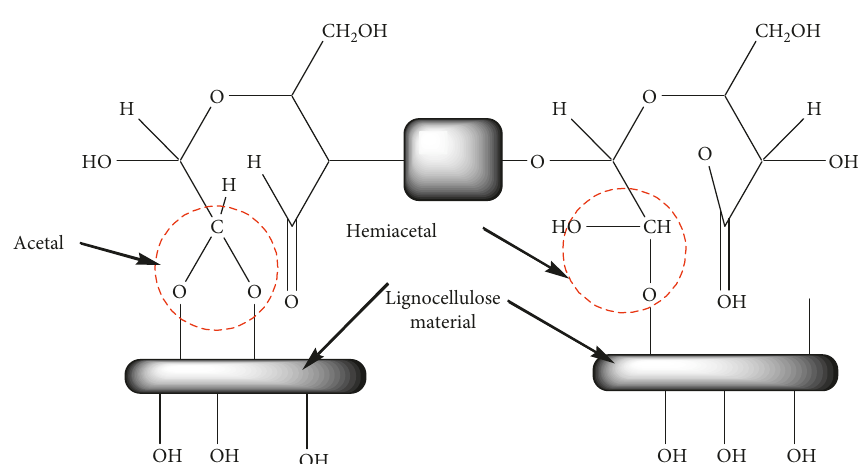
Figure 3: Acetal and hemiacetal bondage between lignocellulose material and modified